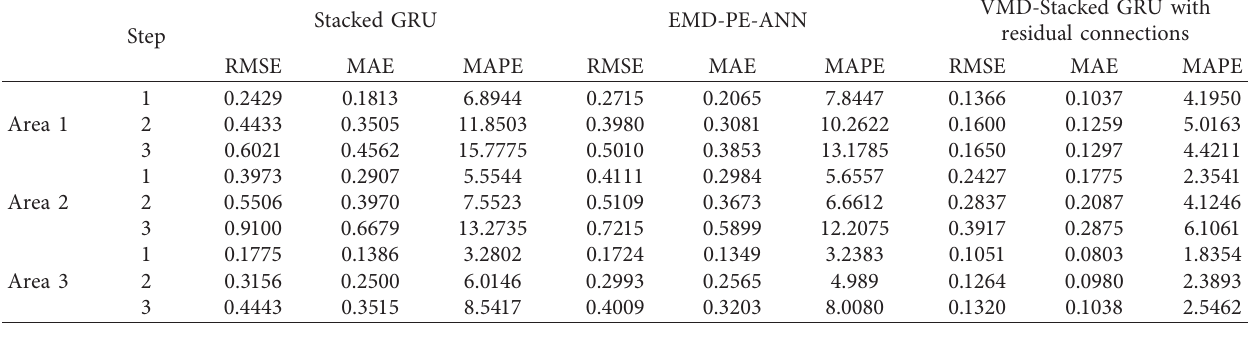
Table 8: Comparison of the proposed model and other models (c).